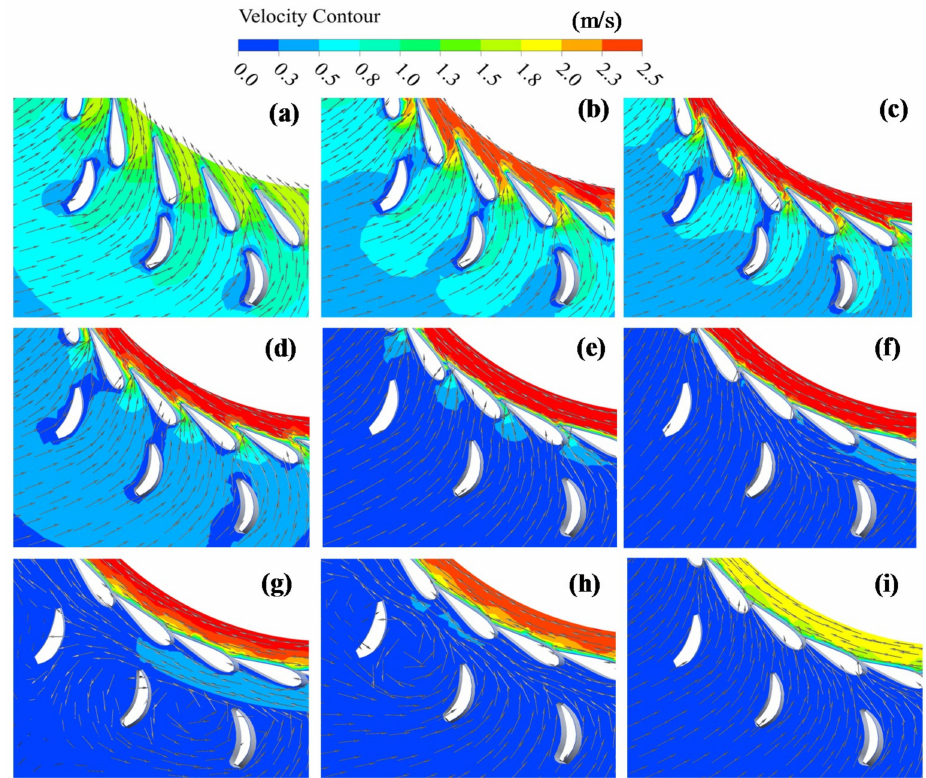
Figure 11. Velocity vector between stay vanes and guide vanes at different time: ( a ) t = 0 s, ( b ) t = 1.76 s, ( c ) t = 2.3 s, ( d ) t = 3.2 s, ( e ) t = 4.8 s, ( f ) t = 5.8 s, ( g ) t = 6.4 s, ( h ) t = 7.0 s, and ( i ) t = 9.2